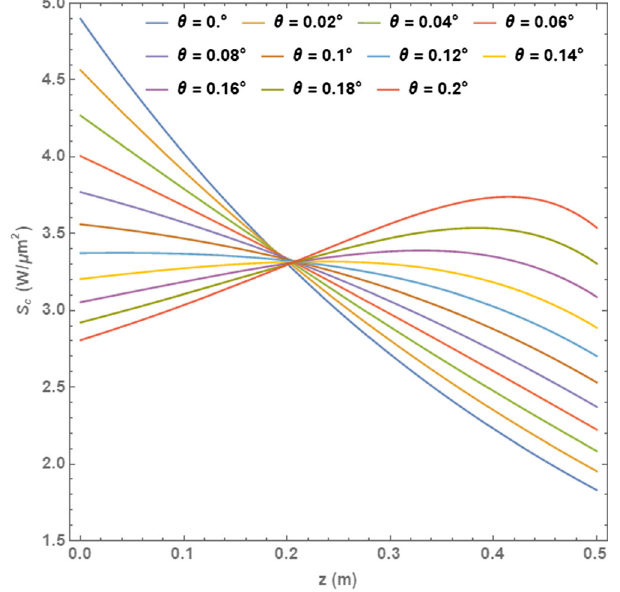
FIG. 13. The modified Poynting vector as a function of z for varying tapering angles θ .